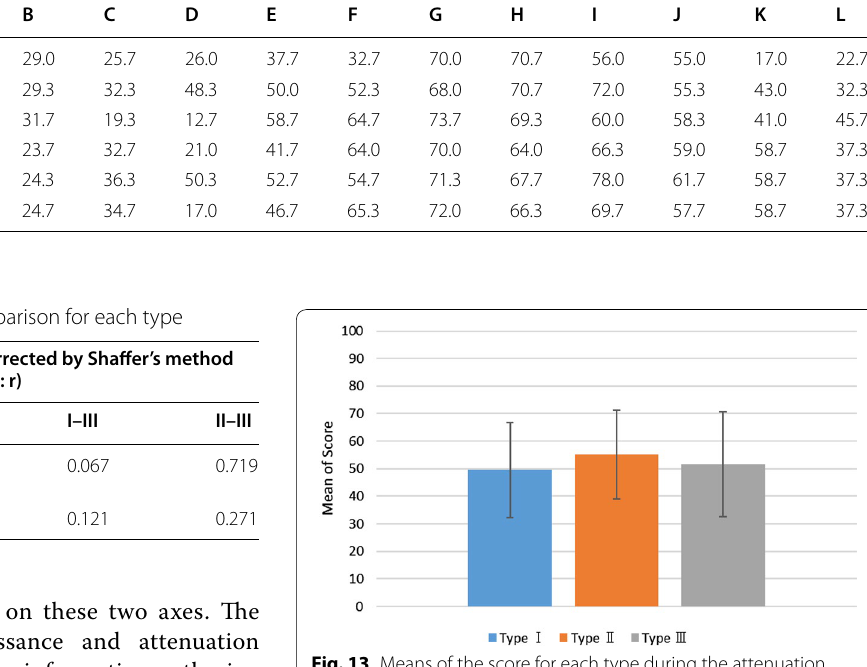
Fig. 13 Means of the score for each type during the attenuation